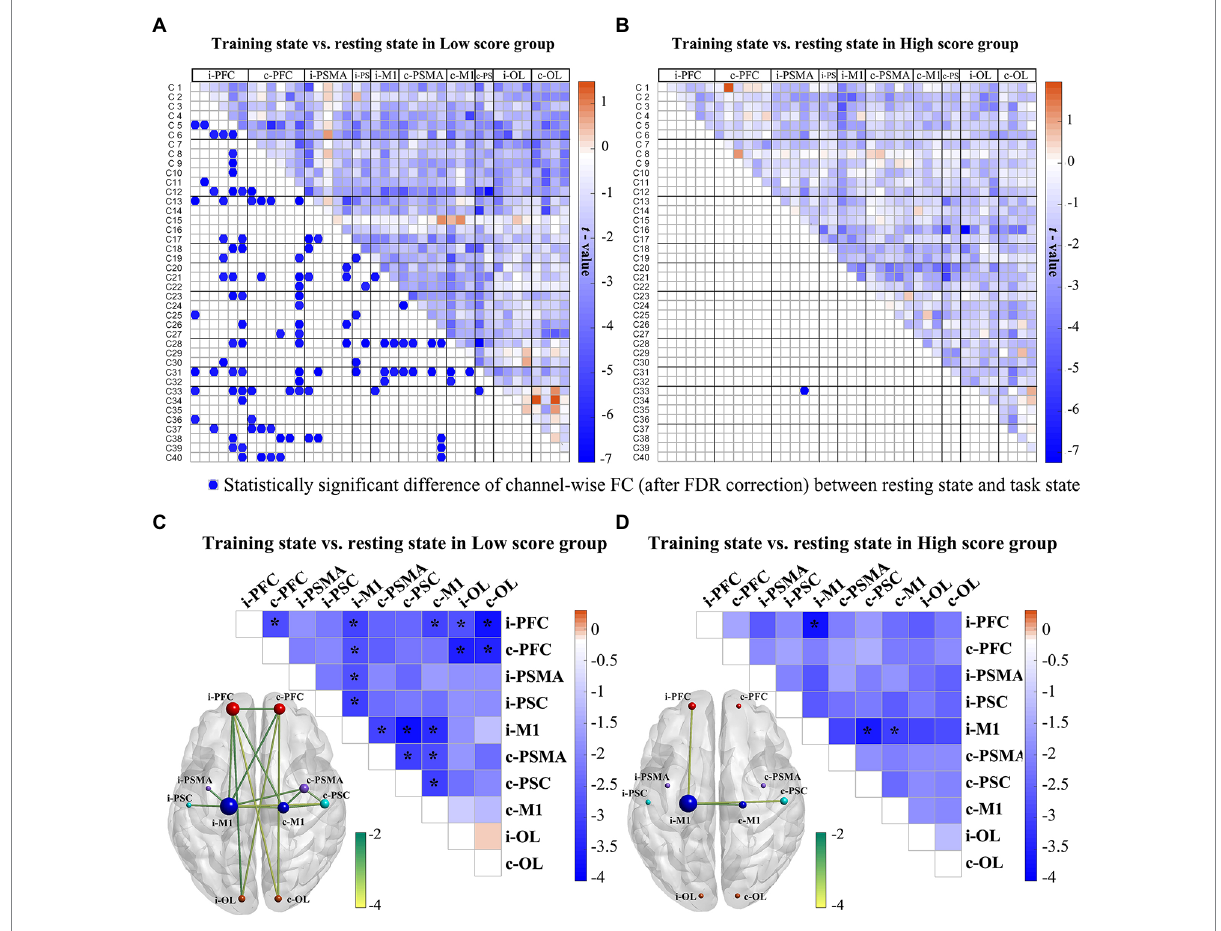
FIGURE 3 Changes in channel-wise FC (A, B) and region-wise FC (C, D) in response to RAT for the low score and high score groups. In the first row, the upper triangle represents the t -value of channel-wise FC between the two states, while the blue dot on the bottom triangle represents the statistically significant difference of channel-wise FC after FDR correction between the two states in each stroke group. The second row displays the t -values of region-wise FC between the two states. The *represents the statistically significant difference of region-wise FC after FDR correction between the two states in each stroke group. The size of a node indicates how many significant edges are connected to this region. Different node colours represent different brain regions. *FDR-corrected p <